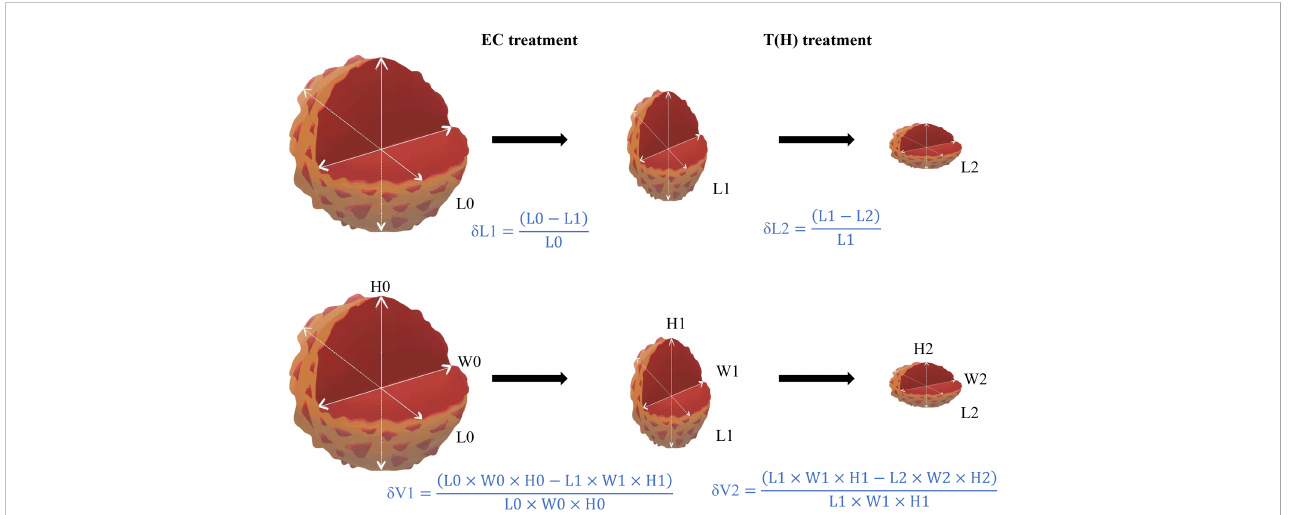
FIGURE 2 Methods for calculating diameter change rate ( d L) and the volume change rate ( d V). Abbreviations: EC, epirubicin and cyclophosphamide; T(H), taxanes (Trastuzumab); L, longest diameter; H, height; W, width; d L1, diameter change rate of EC treatment; d L2, diameter change rate of T(H) treatment; d V1, volume change rate of EC treatment; d V2, volume change rate of T(H)